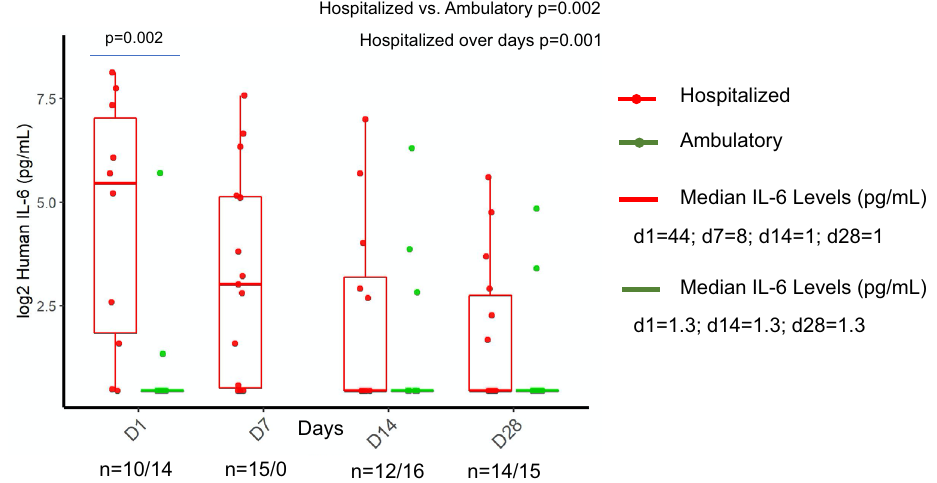
Figure 5. Longitudinal monitoring of interleukin-6 in hospitalized and ambulatory COVID-19 patients. Figure was created using ggplot2 package version 3.3.0. supported on R program software 38